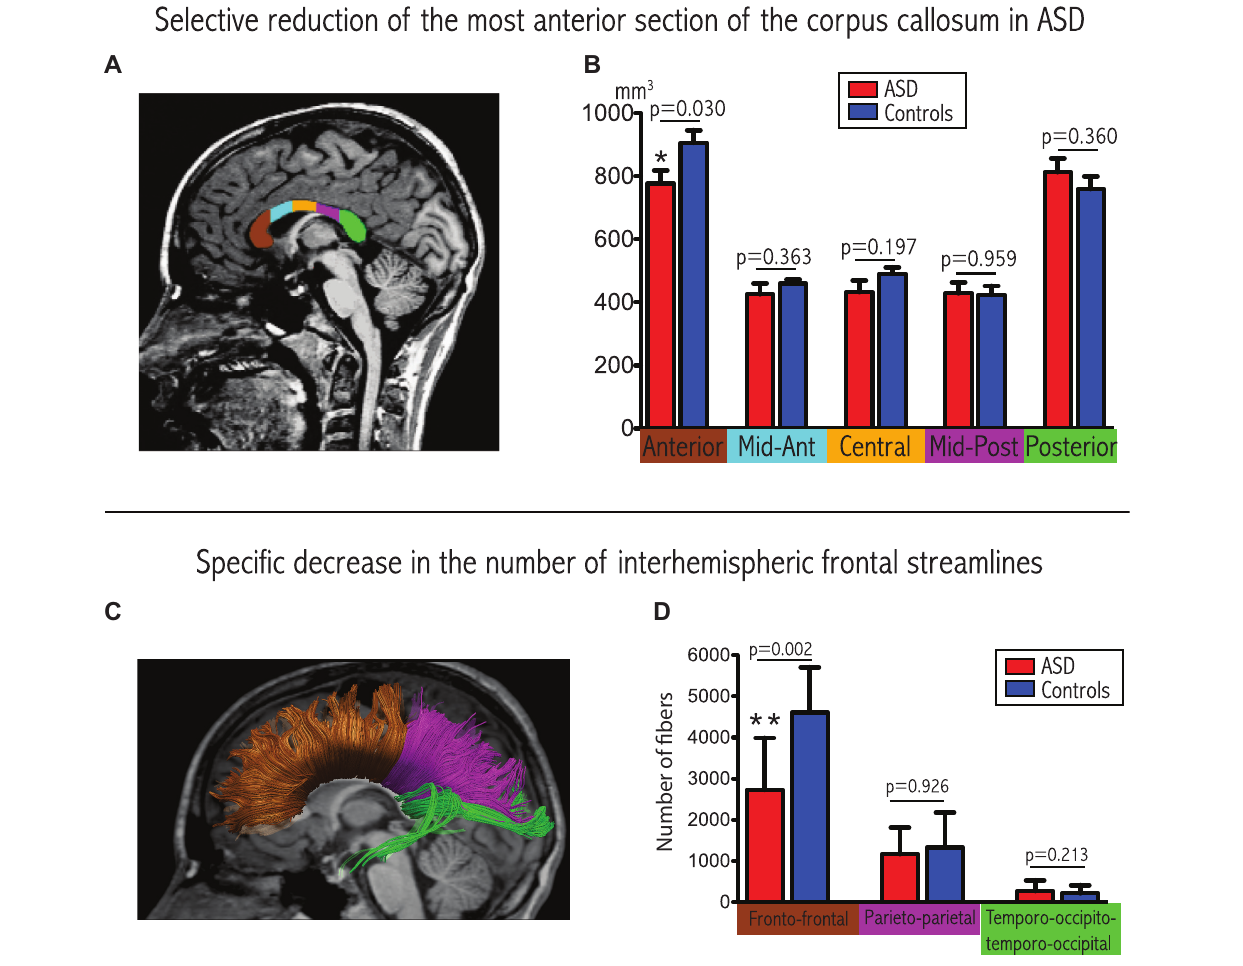
FIGURE 1 | Convergentevidence for disrupted connectivity at the level of inter-hemispheric frontal connectivity in ASD . (A) Example of subdivision of the five sections of the corpus callosum displayed on a mid-sagittal slice. (B) Boxplots depicting volumetric measurements for the five sections in the two groups. The p -values are extracted from the MANCOVA (with correction